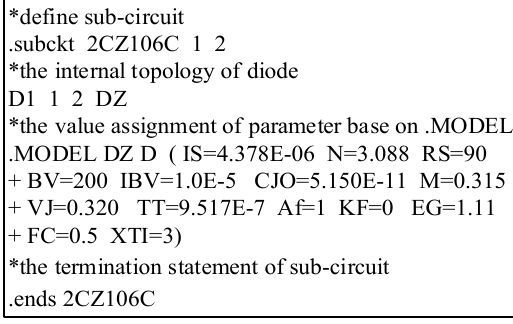
Figure 16. The EMC model of the diode 2CZ106C. Table 4. Model parameters of diode 2CZ106C.